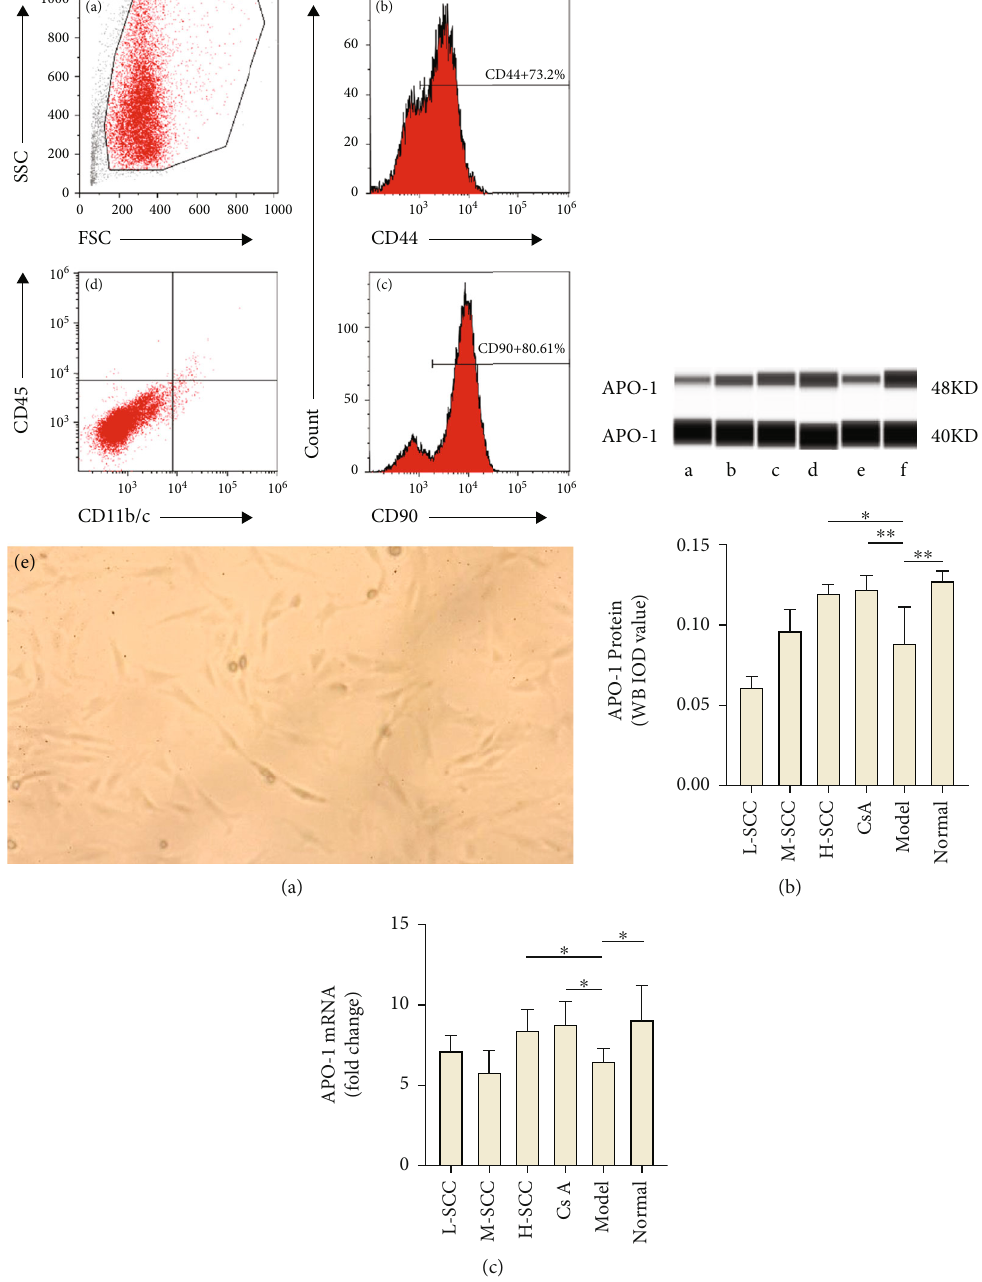
Figure 3: (a) Morphological and immunological identi fi cation of MSC; a, remove debris with FSC as well as SSC and circle out the target cells; b and c, MSC positively for CD44 and CD90; d, negative expression of CD45 and CD11b/c; e, typical MSC with spinning cone morphology. (b) Western blot was used to visualize the accumulation of APO-1 proteins in MSC in di ff erent groups; a, L-SCC group; b, M-SCC group; c, H-SCC group; d, CsA group; e, model group; f, normal group. Chemiluminescent signals were detected and quanti fi ed with Compass software. (c) Comparison of APO-1 protein and mRNA expression on MSC in each group of rats ( n = 6 ). Statistically signi fi cant di ff erences are indicated by ∗ P < 0 : 05 ; ∗∗ P < 0 : 01